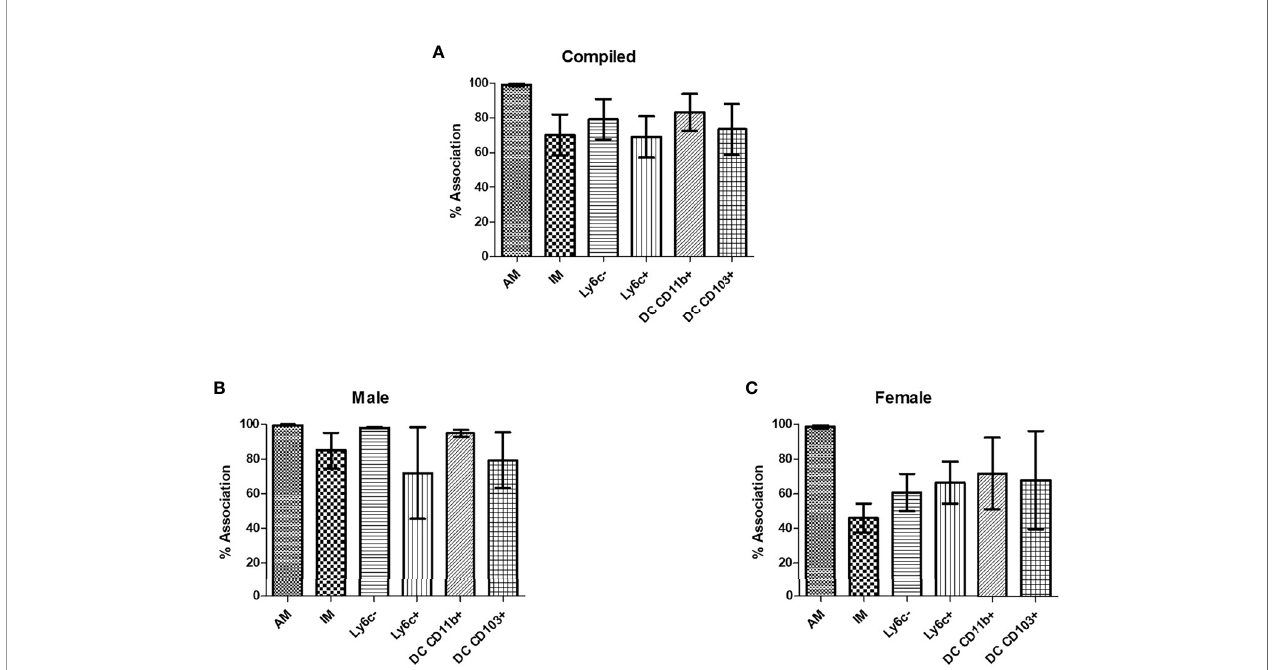
FIGURE 3 | Murine pulmonary phagocyte subsets interact with C. neoformans ex vivo . Pulmonary phagocyte subsets were puri fi ed from both male and female BALB/c mice (20 mice pooled per experiment) and incubated with mcherry expressing C. neoformans (Kn99mCH) for 2hrs at 37°C, 5% CO 2 at a ratio of 1:1. Following incubation, cells were stained for surface markers and analyzed for cryptococcal association via fl ow cytometry. Association is de fi ned as cryptococcal cells internalized and/or attached to the phagocytes. (A) Percent association of C. neoformans strain H99 with each phagocyte subset from combined experiments from both male and female mice. (B) C. neoformans strain H99 association percentages for male phagocyte populations. (C) C. neoformans strain H99 association percentages for female phagocyte populations. Alveolar macrophage (AM), interstitial macrophage (IM), Ly6c - monocyte-like macrophages (Ly6c - ), Ly6c + monocyte- like macrophages (Ly6c + ), CD11b + DCs, and CD103 + DCs. The data are means ± standard errors of the means (SEM) for three independent experiments (n=3) each from both male and female